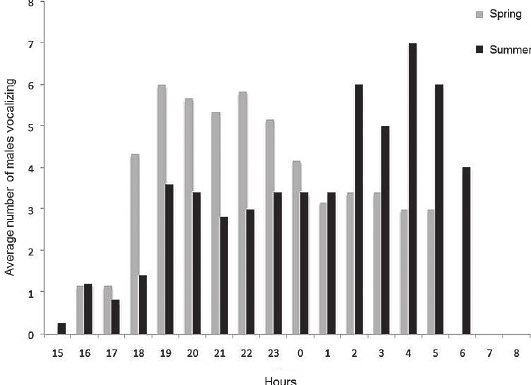
figure 2 - Daily cycle of calling activity of Lithobates catesbeianus from southern Brazil in spring and summer between August 2010 and July